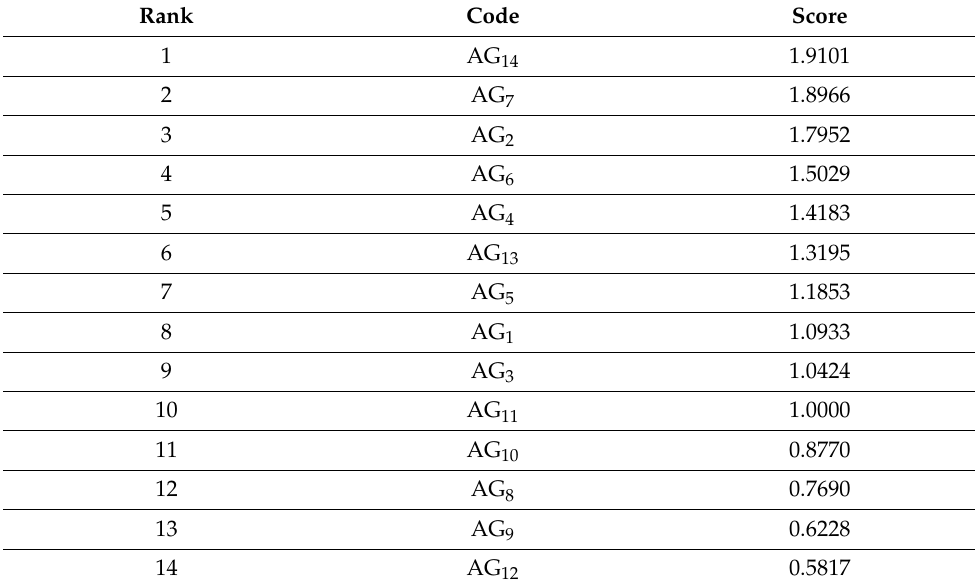
Table 15. Rank and score before alliances.